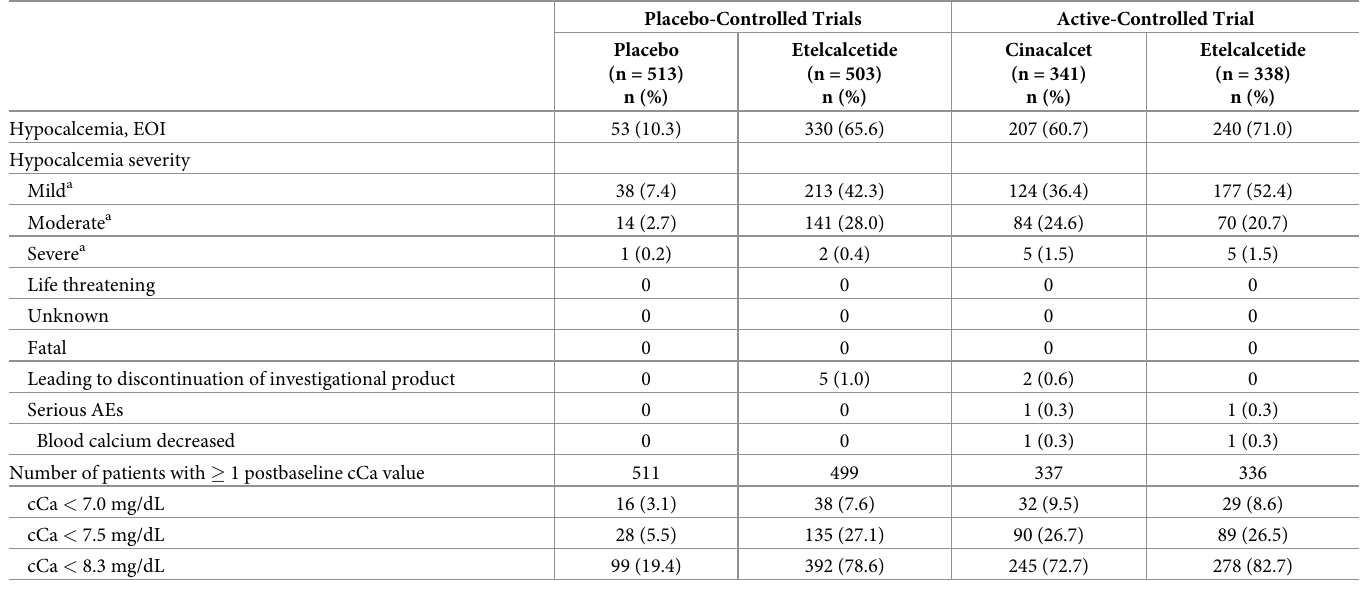
Table 3. Hypocalcemia in the placebo- and active-controlled